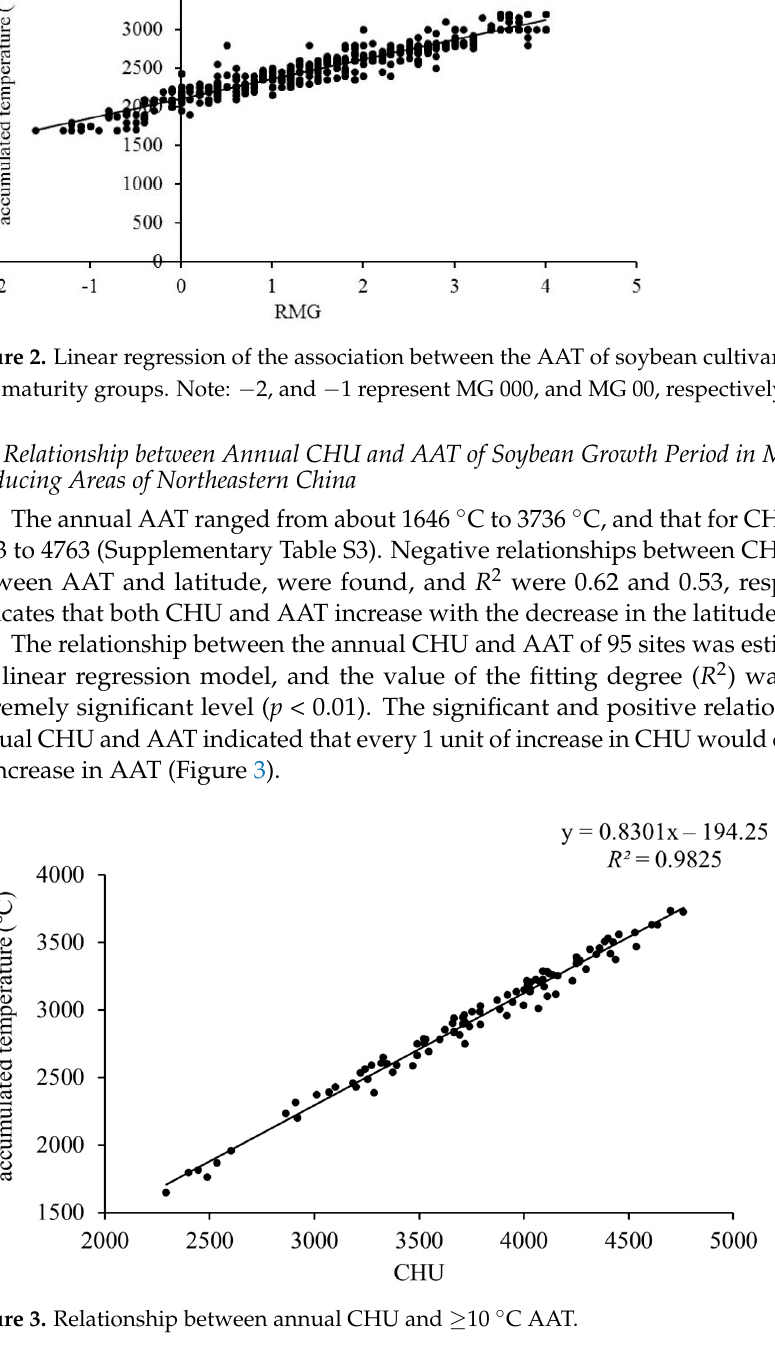
Figure 4. Distribution of annual AAT in Northeast China.